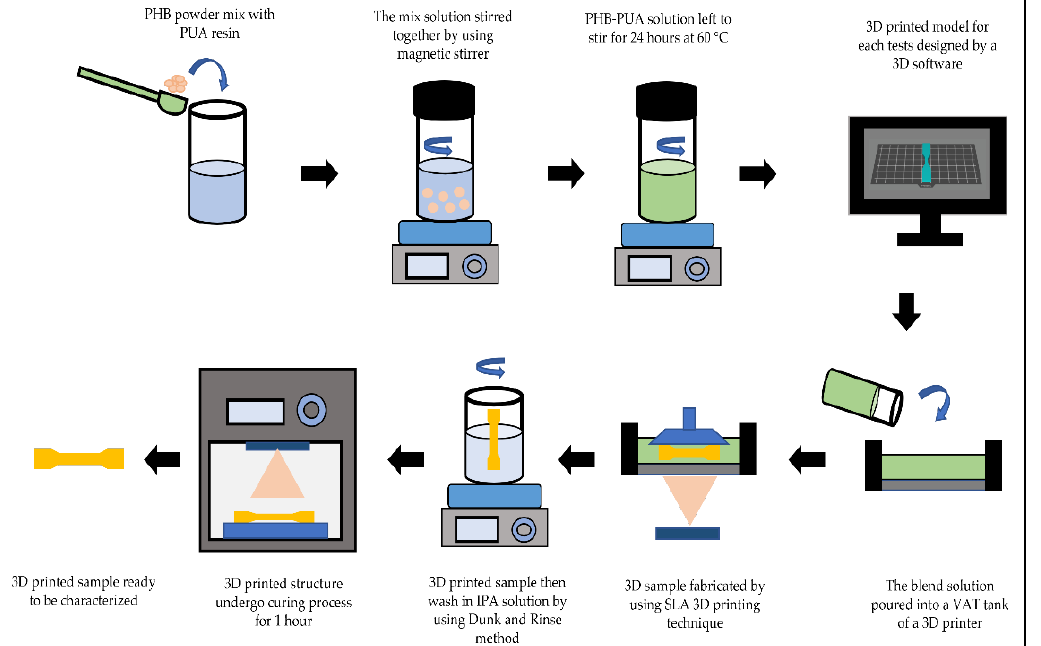
Figure 1. The overall procedure of 3D-printed PHB/PUA samples.